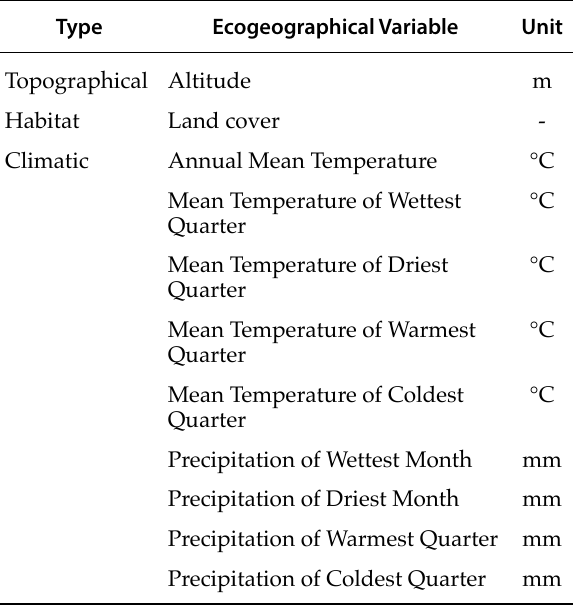
Table 1. List of Ecogeographical Variables used in this study, their types and measurement